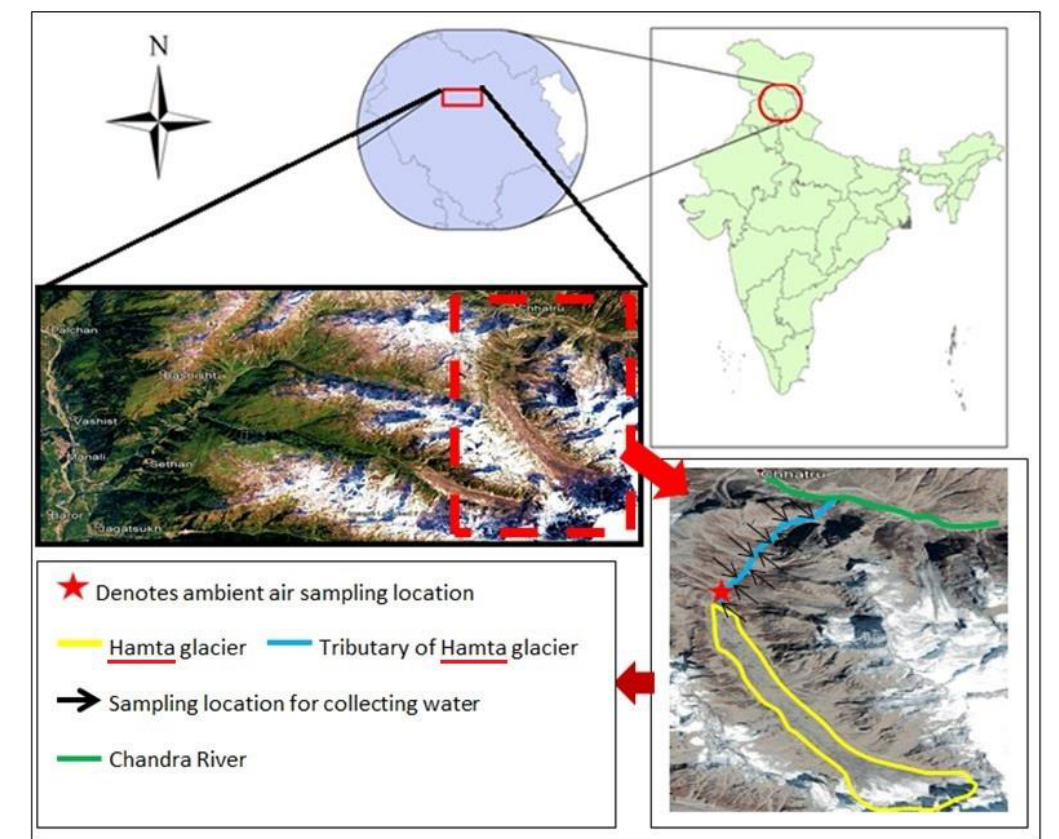
Figure 2. Geographic location of the site for collecting the water samples.